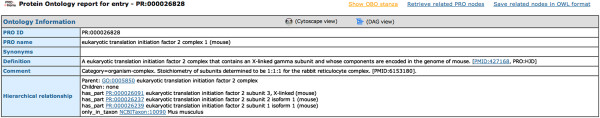
Protein ontology report for entry PR:000026828. Ontology information for the Protein Ontology term 'eukaryotic translation initiation factor 2 complex 1 (mouse)', showing parent GO term and has_part links to other PR terms [25].